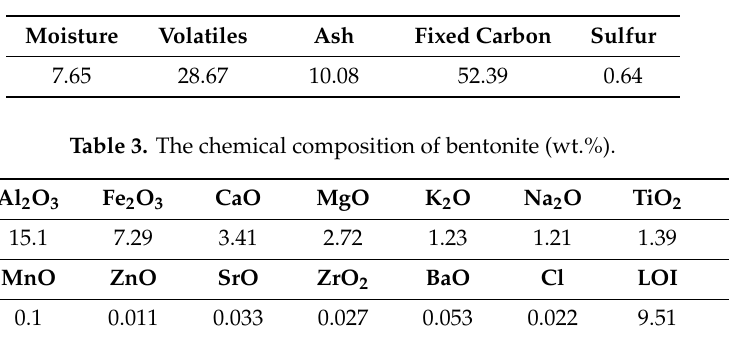
Table 2. The proximate analysis of coal (wt.%).